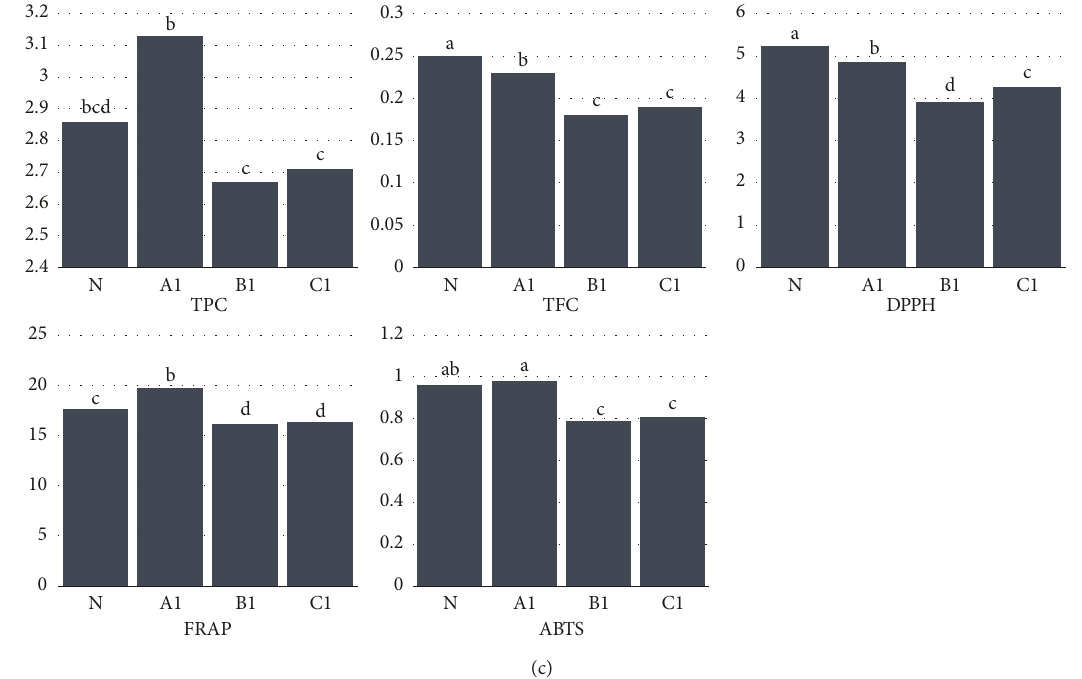
Figure 3: Levels of L -ascorbic acid, TPC, TFC, DPPH free radical scavenging capacity, FRAP, and ABTS free radical scavenging capacity in whole litchi fruit (a), longan (b), and rambutan (c) after different pretreatments: refrigeration (A), refrigeration-UV (B), UV-refrigeration, (C) and control (N).